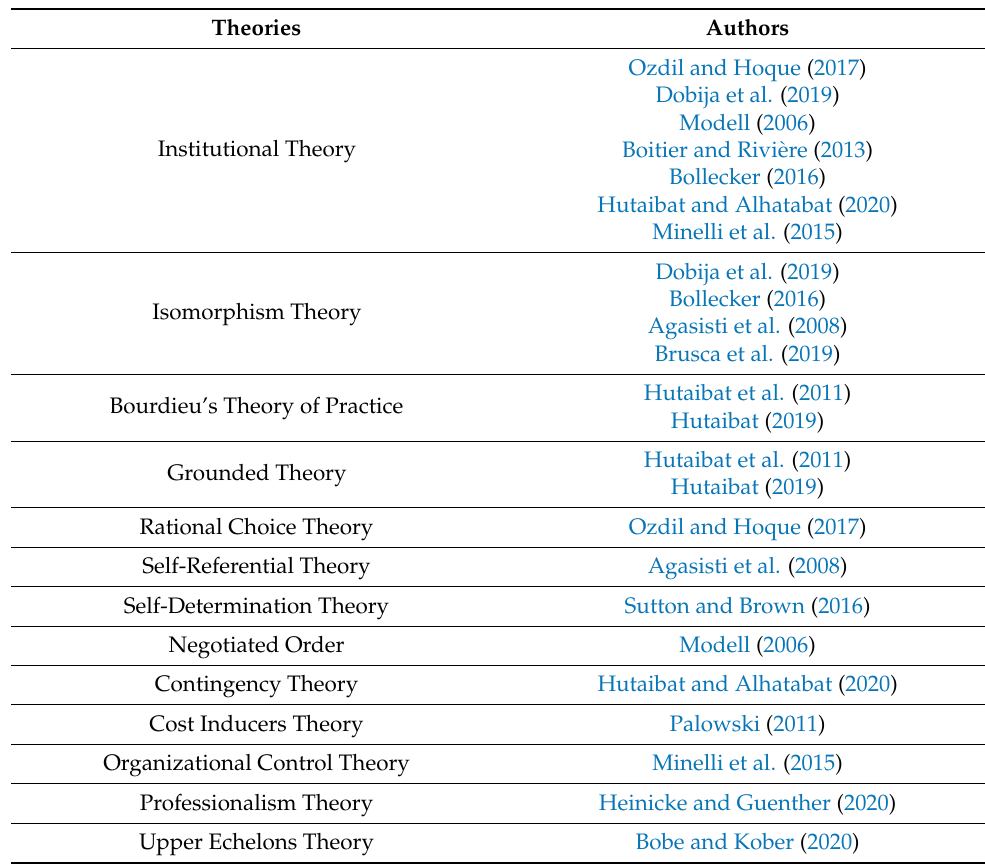
Figure 7. Thematic